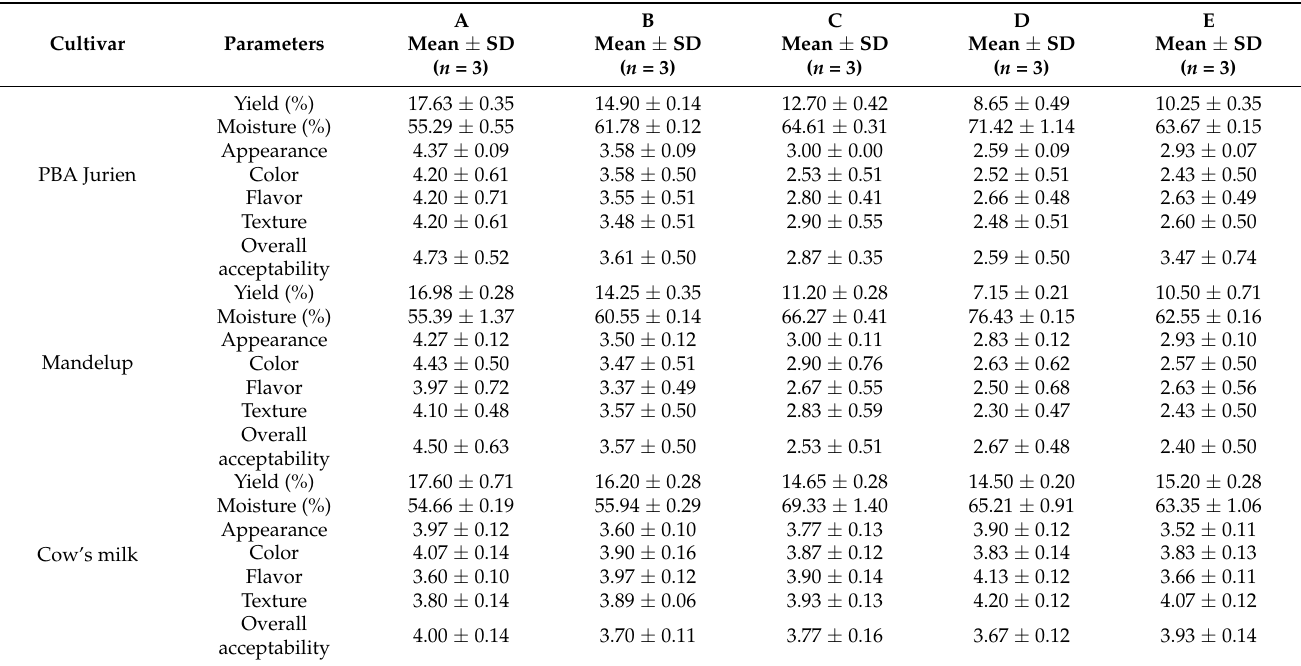
Table 3. Yield and sensory analyses of cheeses produced by different coagulation methods, of lupin milk from two cultivars of L. angustifolius and cow’s milk after storage at 4 ◦ C for 2 weeks.